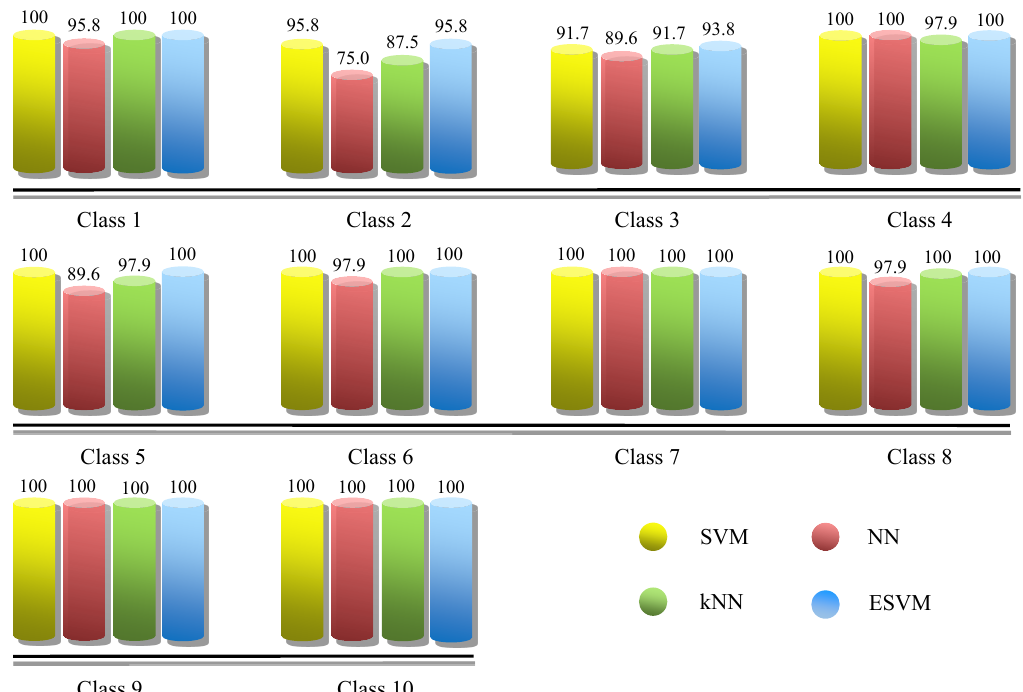
Figure 12. The average recognition rates by the four classifiers for the ten bearing fault classes.